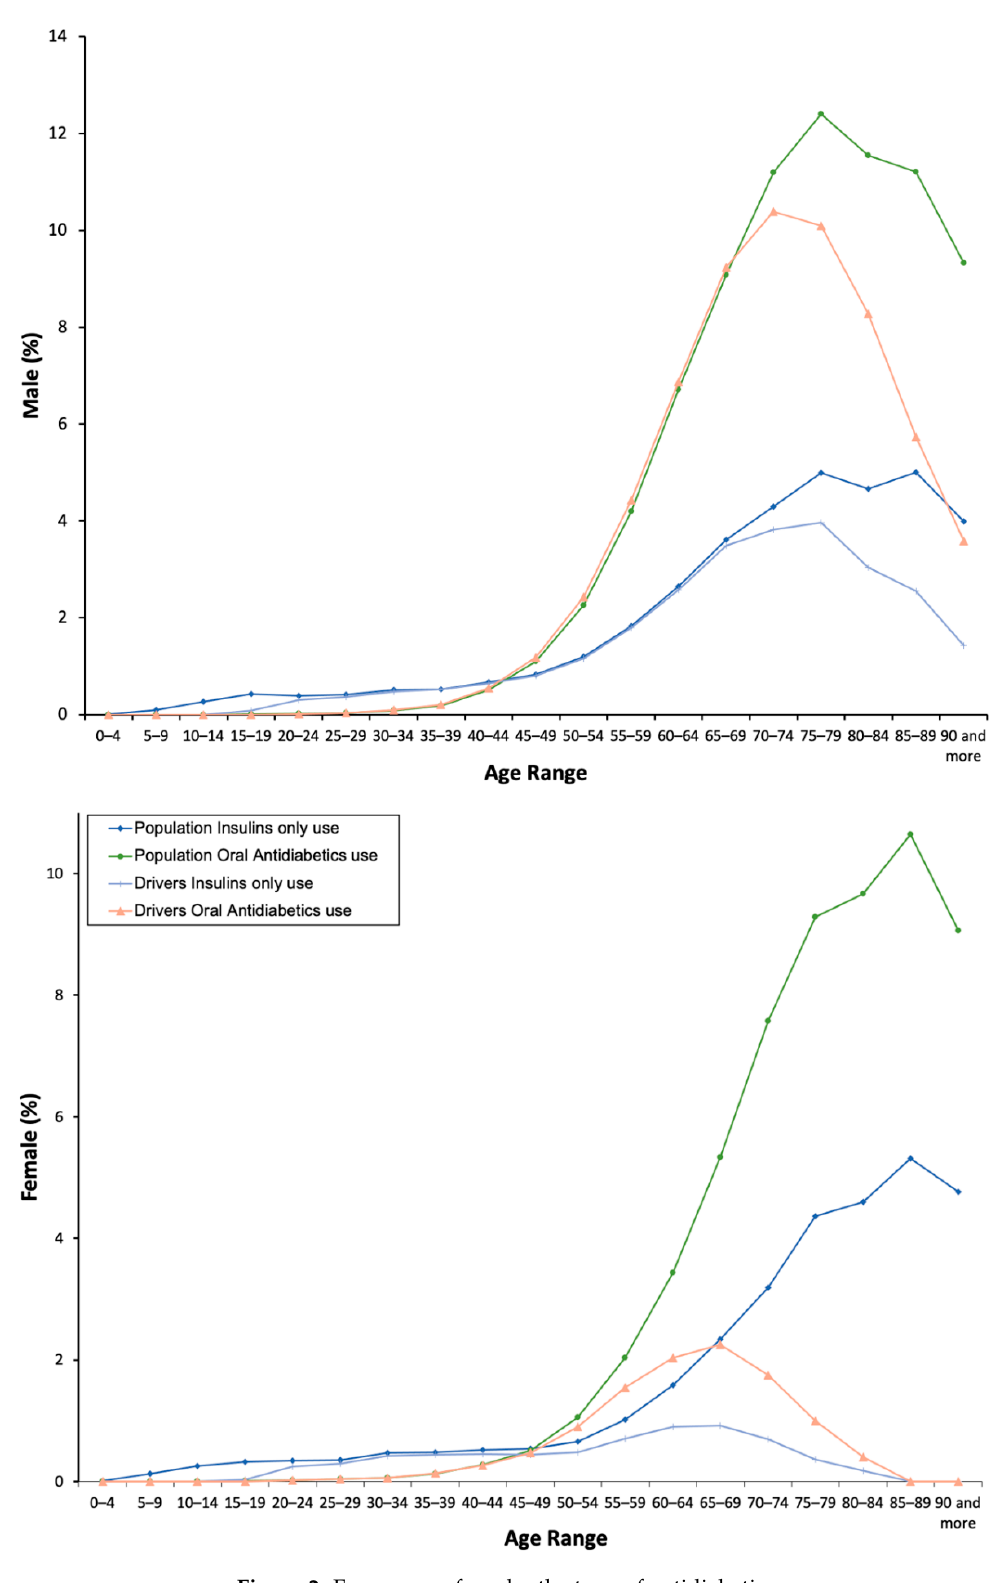
Figure 2. Frequency of use by the type of antidiabetic.